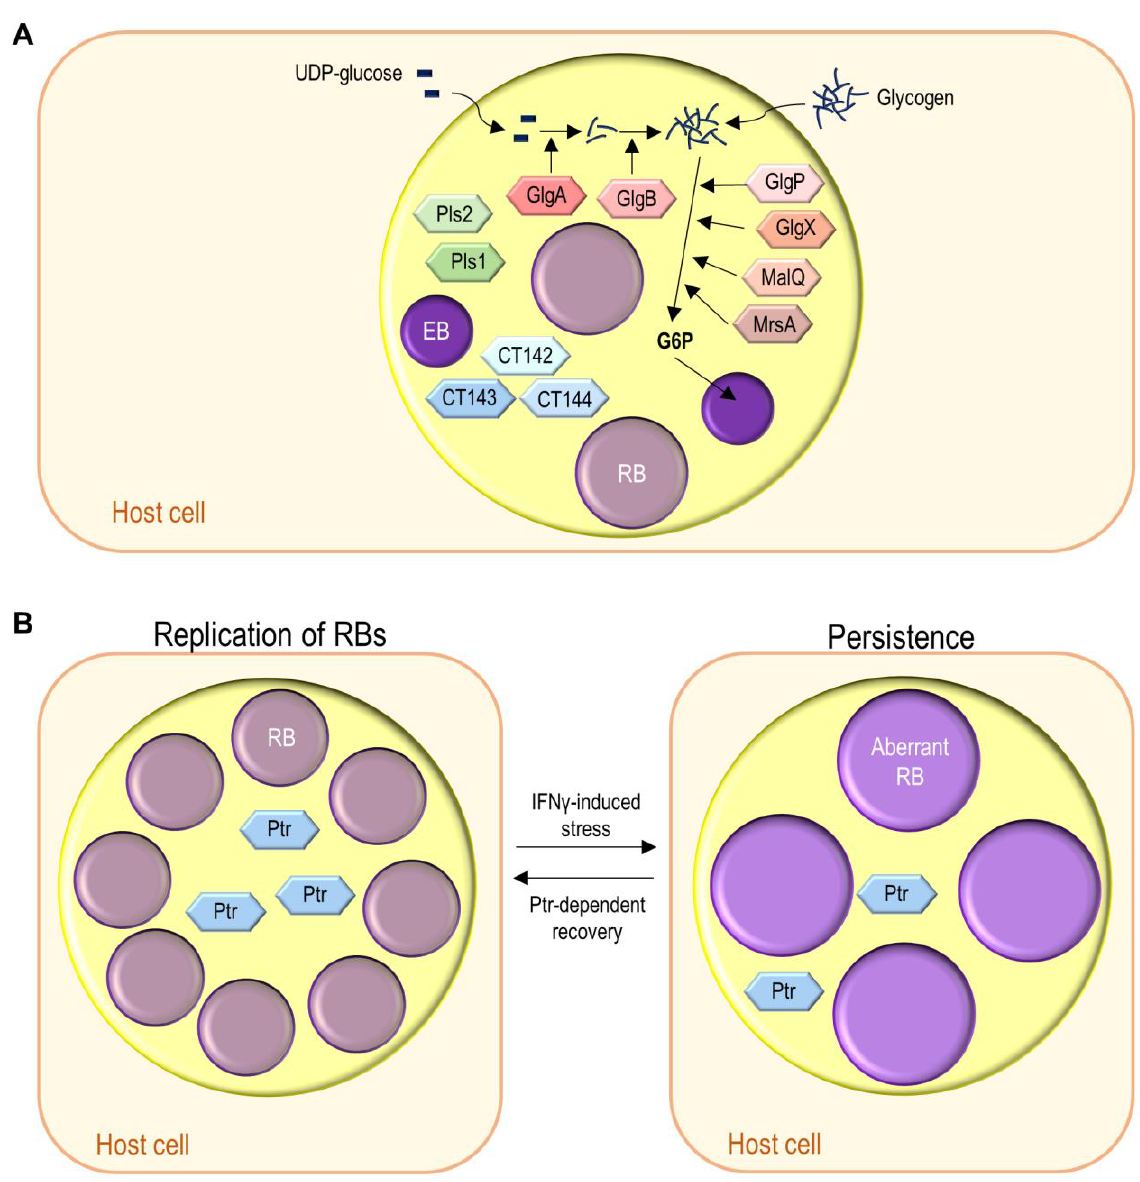
FIGURE 5: C. trachomatis proteins secreted into the inclusion lumen. (A) C. trachomatis glycogen metabolizing enzymes shown (GlgA and GlgX) or deduced (GlgB, GlgP, MalQ, and MrsA) to localize in the inclusion lumen, and C. trachomatis proteins (Pls1, Pls2, CT142, CT143, and CT144) of unknown function appearing in the inclusion lumen, by IF microscopy, as large globular structures; G6P, glucose 6- phosphate. (B) C. trachomatis putative protease Ptr that specifically mediates the recovery from IFNγ -induced chlamydial persistence. See list of abbreviations, main text, and Table 2 for